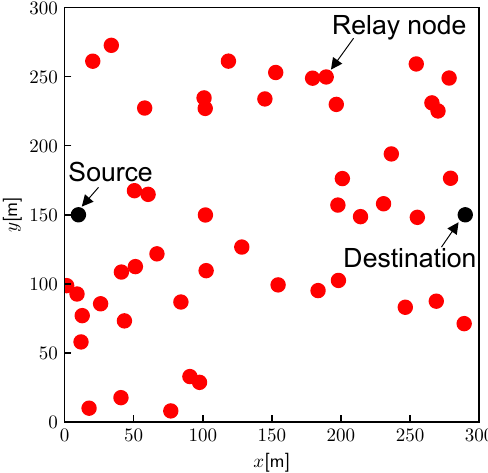
Figure 9. Node deployment